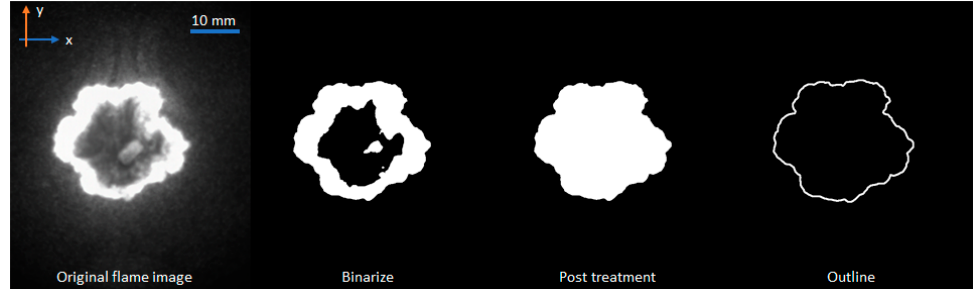
Figure 3. Sketch of the image processing steps for the analysis of spark-ignited flame morphology.